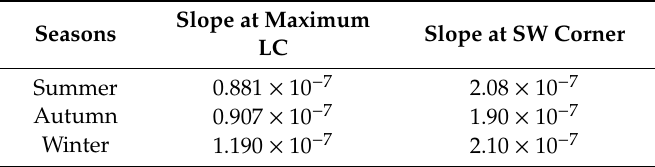
Table 1. Geopotential gradient for summer, autumn and winter at the location of the maximum Leeuwin current (LC) speeds and at the south-west corner. The geopotential anomaly was calculated between the surface and 300 dB along the LC